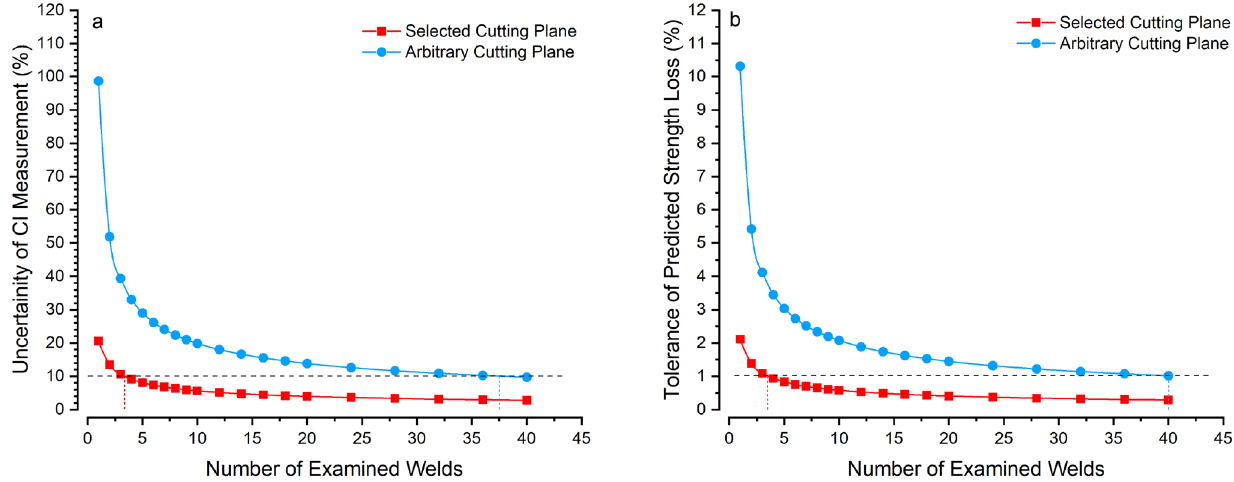
Fig. 6 Predicted uncertainty associated with a cracking index calculation and b tensile shear strength loss associated with LME cracking from the number of welds examined to determine weld cracking